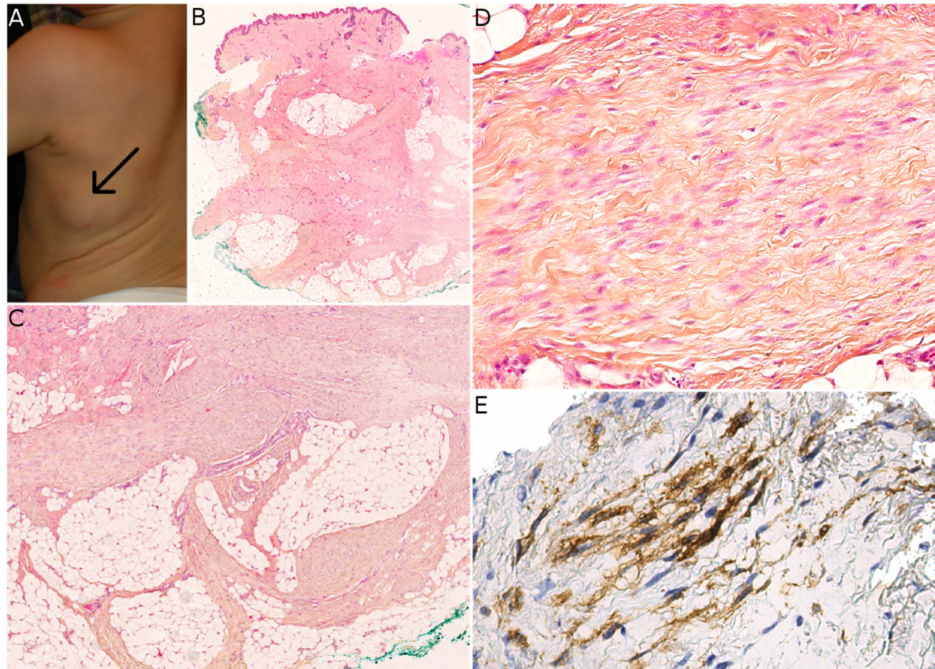
Figure 6. Plexiform myofibroblastoma (PM). ( A ) Clinical presentation as a sub-scapular subcutaneous mass in an infant (courtesy of the Department of Maxillofacial Surgery, Necker-Enfants Malades hospital, Paris, France). ( B ) Low-power view of the lesion showing location in the subcutis (HES × 50). ( C ) Typical plexiform architecture with extension into the subcutaneous septa (HES × 100). ( D ) High- power view showing the bland morphology of the cells and the characteristic collagenous stroma (HES × 200). ( E ) Positivity for smooth muscle actin in the spindle cells (SMA ×